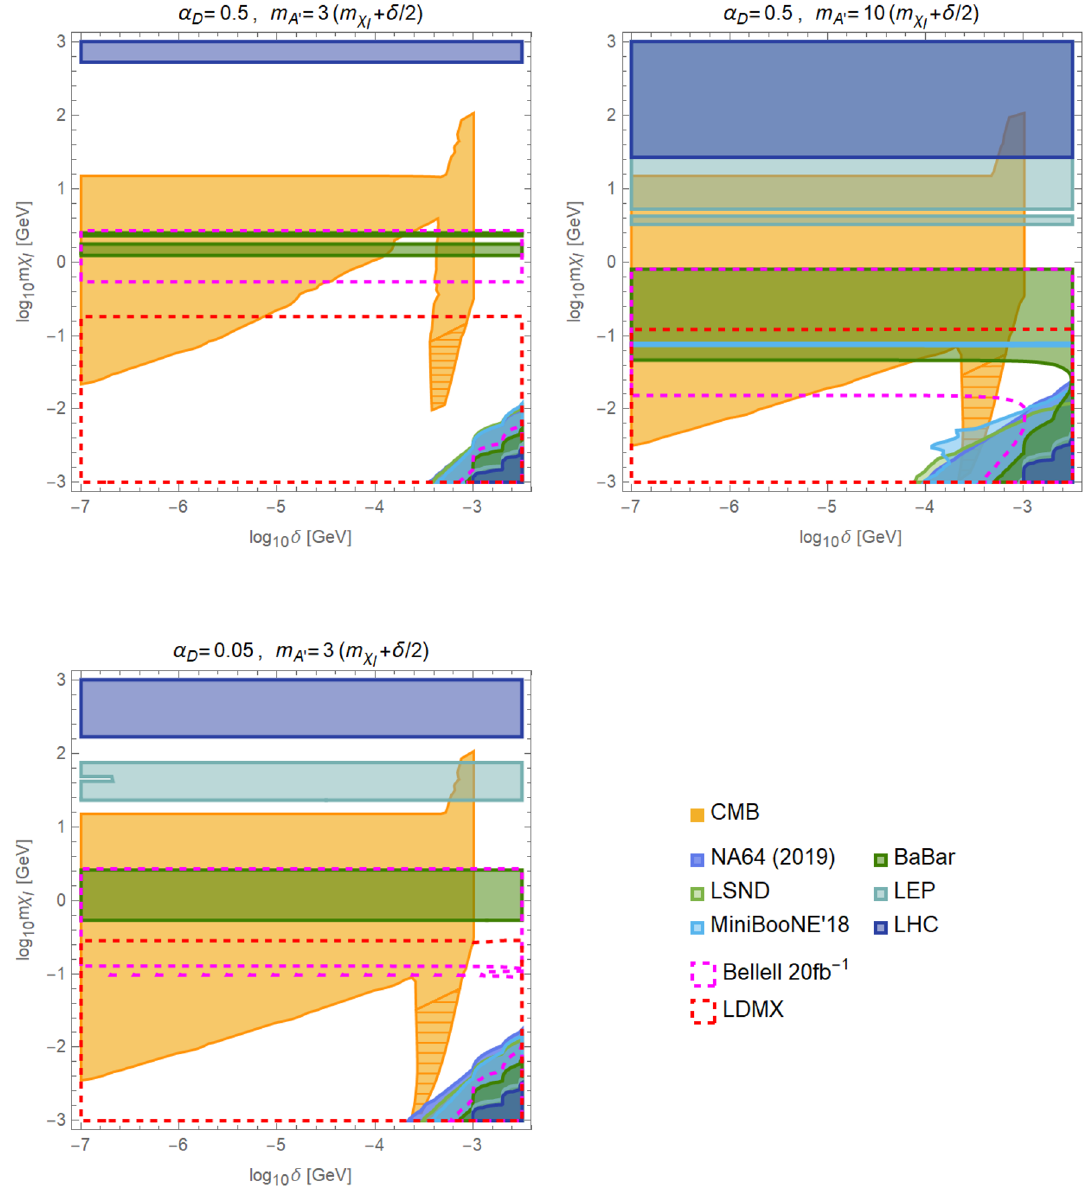
Figure 22 . Regions of parameter space excluded by CMB observations and accelerator-based probes, as in figure 7 but for different values of α CMB observations and the color shaded regions are ruled out by different accelerator-based probes. The dashed contours correspond to Belle II and LDMX